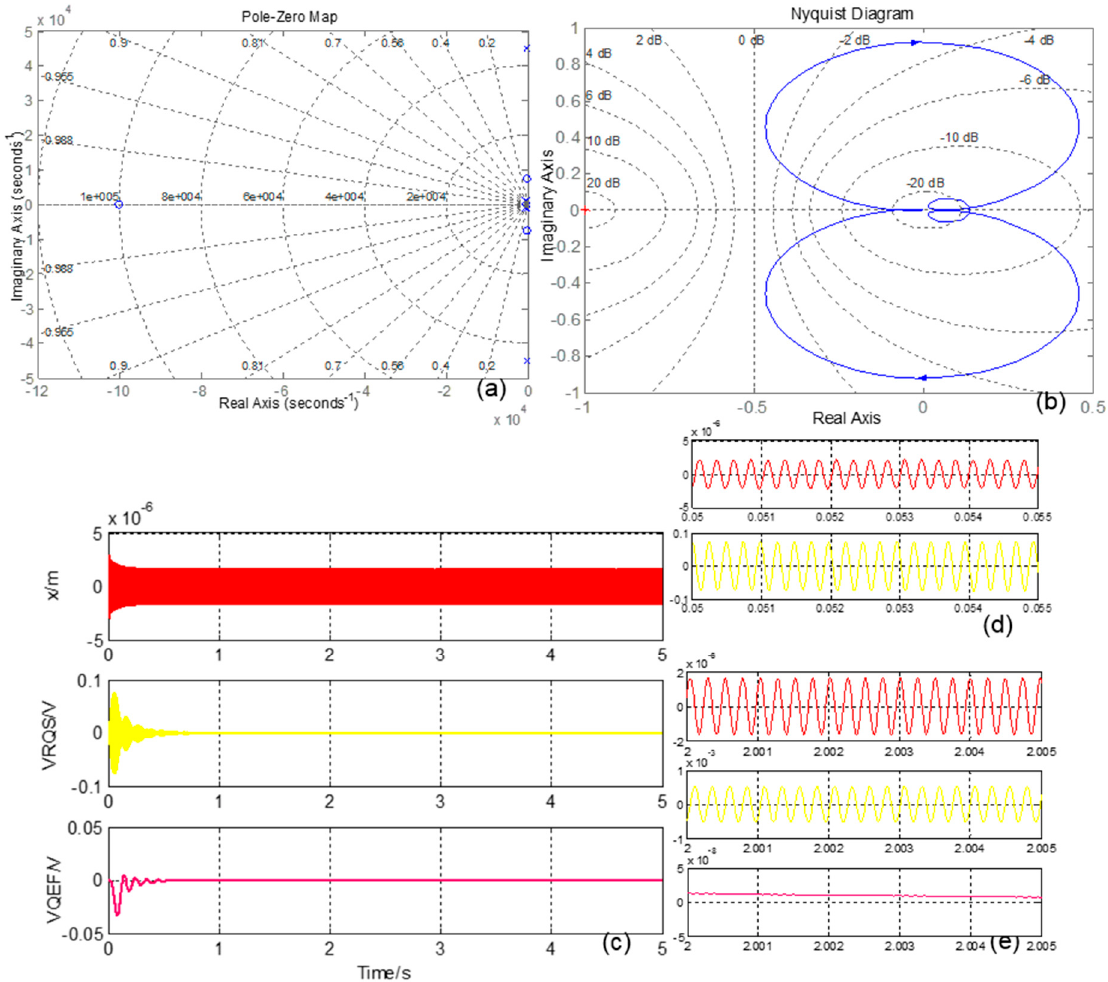
Figure 10. ( a ) QFC system Pole-Zero map; ( b ) QFC system Nyquist Diagram; ( c ) QFC system simulation curves; ( d ) QFC system start-up stage enlarged curves; ( e ) QEF system stable stage enlarged curves.